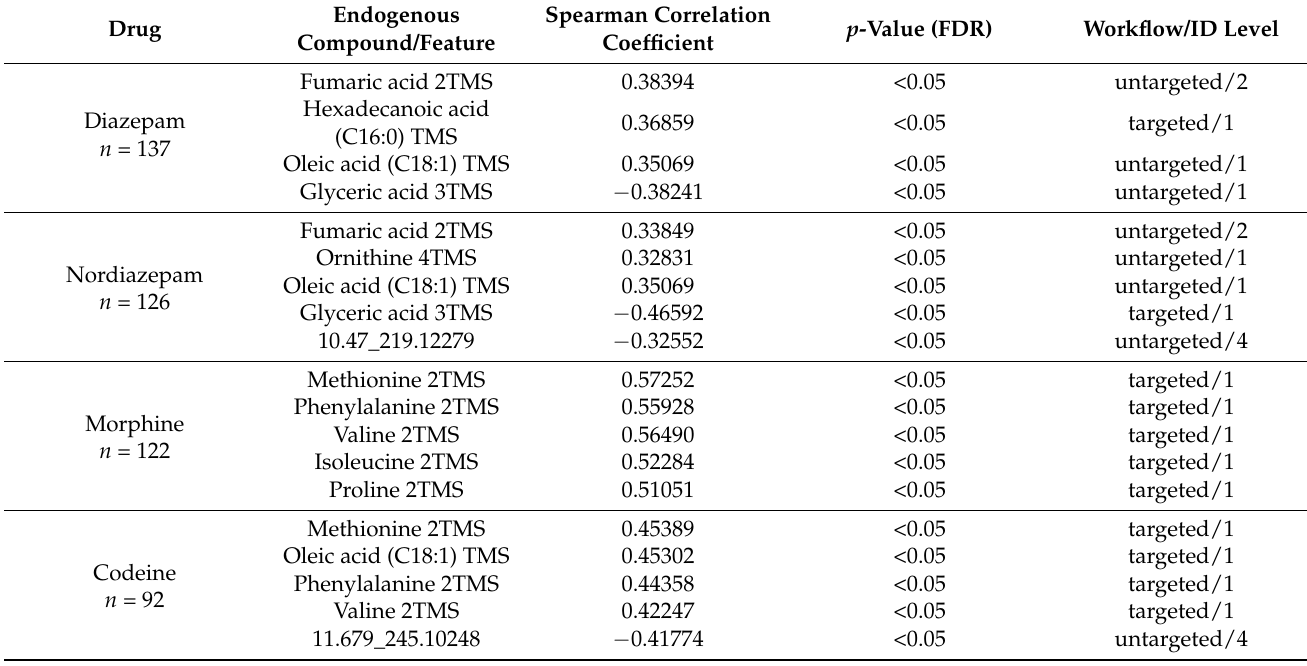
Table 3. Endogenous compounds/features that were found to have the highest spearman correlation coefficients with the corresponding drugs (of abuse); p -values are corrected for multiple testing using false discovery rate (FDR); it is indicated with which workflow the endogenous compound was found and the identification level according to the chemical analysis working group (CAWG) of the metabolomics standards initiative (MSI)